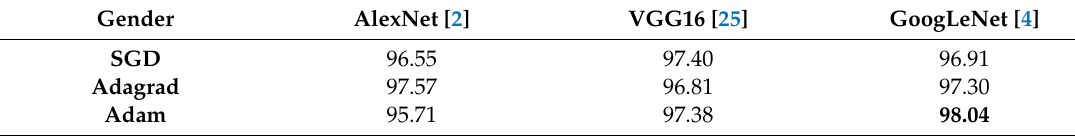
Table 10. Classification results of the Morph database by the different methods.